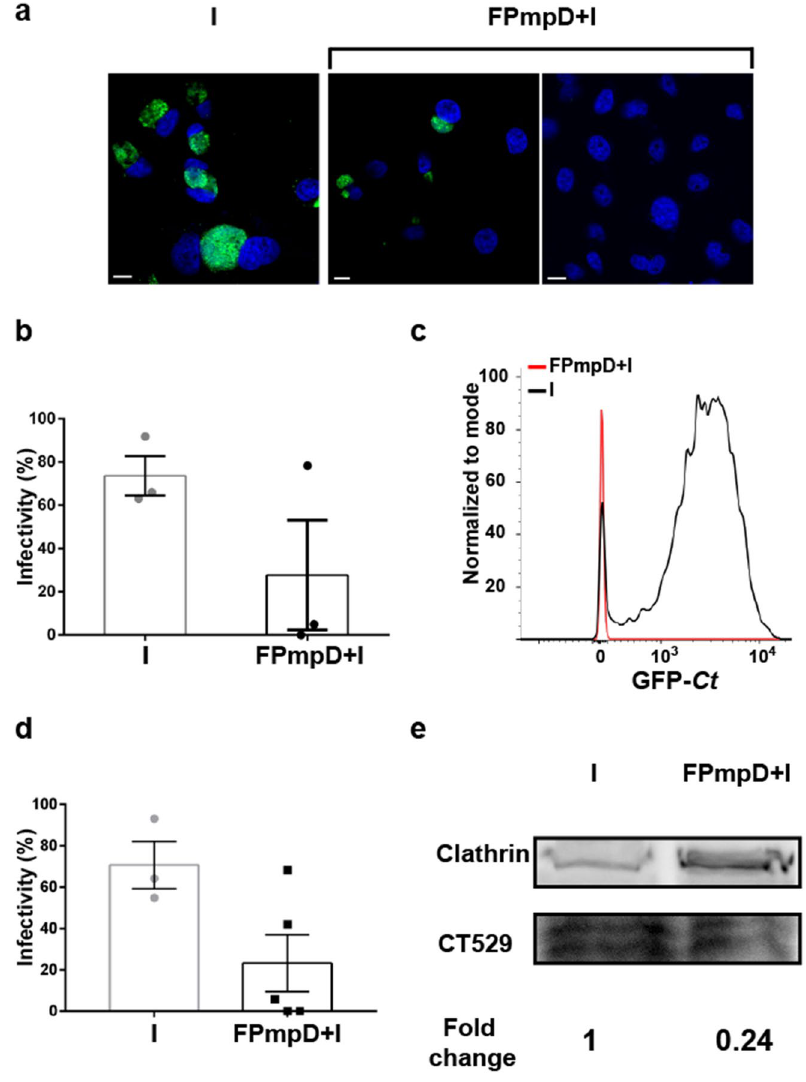
Figure 6. Infectivity assay. HeLa cells were incubated with cervicovaginal secretions collected seven days post GFP- Ct challenge from non-vaccinated (I) and FPmpD-vaccinated (FPmpD + I) mice. At 24 h post infection, cell cultures were fixed and inclusions developed by infective bacteria shed in vaginal fluids were detected by confocal microscopy ( a , b ) and by flow cytometry ( c , d ). ( a ) Confocal images show the number and size of chlamydial inclusions developed by incubation with cervicovaginal secretions from one non-vaccinated infected mouse (I, left panel) and two FPmpD-vaccinated infected mice (FPmpD + I, middle and right panels). ( b ) Infectivity was calculated as the percentage of HeLa cells infected with cervicovaginal secretions from non-vaccinated infected (I) and from FPmpD-vaccinated infected (FPmpD + I) mice. A minimum of 200 cells were counted for each condition. ( c ) A representative flow cytometry profile indicating the normalized green fluorescence intensity that corresponds to GFP- Ct developed in HeLa cells incubated with cervicovaginal secretions from a non-vaccinated infected mouse (I, black line) or from a FPmpD-vaccinated infected mouse (FPmpD + I, red line). ( d ) Percentage of HeLa cells infected with cervicovaginal secretions from non-vaccinated infected (I) and from FPmpD-vaccinated infected (FPmpD + I) mice. At least 10,000 HeLa cells were analyzed per condition. Each dot represents the percentage of cells infected by the cervicovaginal secretion of each mouse. Bar represents means ± SEM of infected cells of each experimental group. ( e ) Detection of Ct proteins in uterine homogenates from non-vaccinated infected (I) and FPmpD-vaccinated infected (FPmpD + I) mice analyzed 14 days post-infection by immunoblot with anti-CT529 antibodies. Clathrin was used as loading